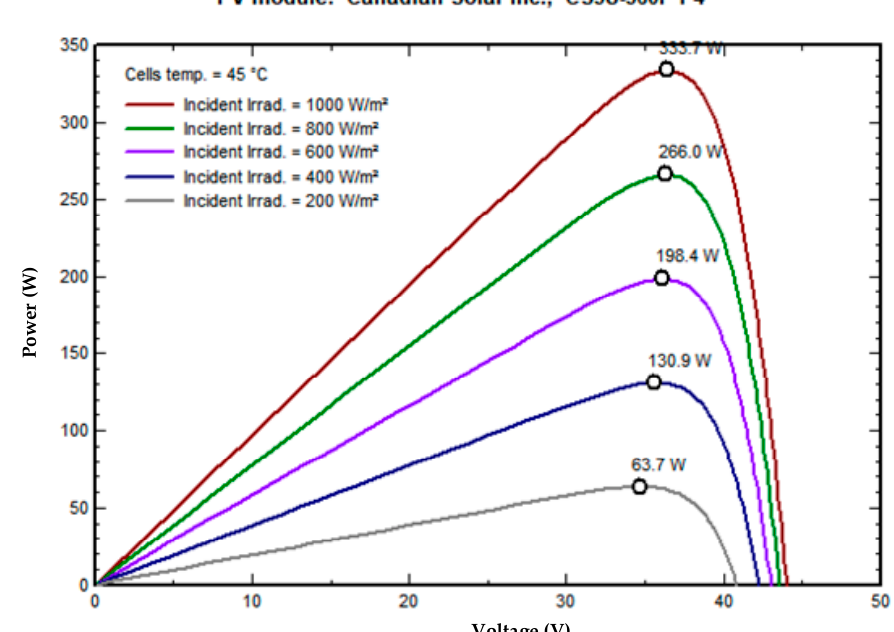
Figure 8. PV characteristics curve for Canadian solar panel CS3U-360P P4.